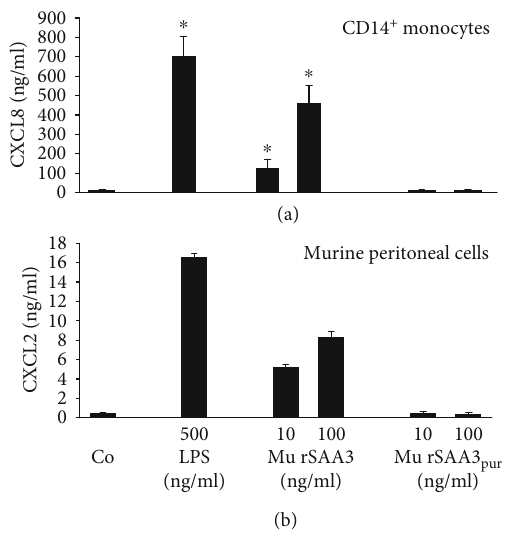
rSAA3 (mu rSAA3 ) does not induce chemokines in leukocytes. pur Human CD14 + monocytes derived from bu ff y coats from healthy individuals (a) or murine peritoneal cells derived from healthy mice (b) were stimulated with LPS (500ng/ml), mu rSAA3 (10 or 100 ng/ml), mu rSAA3 (10 or 100 ng/ml) or were left untreated pur (Co). After 24 h, supernatants were collected and levels of CXCL8 (a) or CXCL2 (b) were determined via speci fi c ELISAs. Data represent the mean production of chemokine ± SEM derived from 4 (a) or 3 (b) independent experiments. Statistically signi fi cant di ff erences from untreated control cells, determined by the Mann- Whitney U test, are indicated by asterisks ( ∗ p < 0 : 05